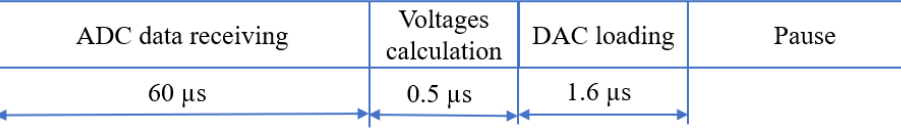
Figure 9. Cyclogram of the control module.